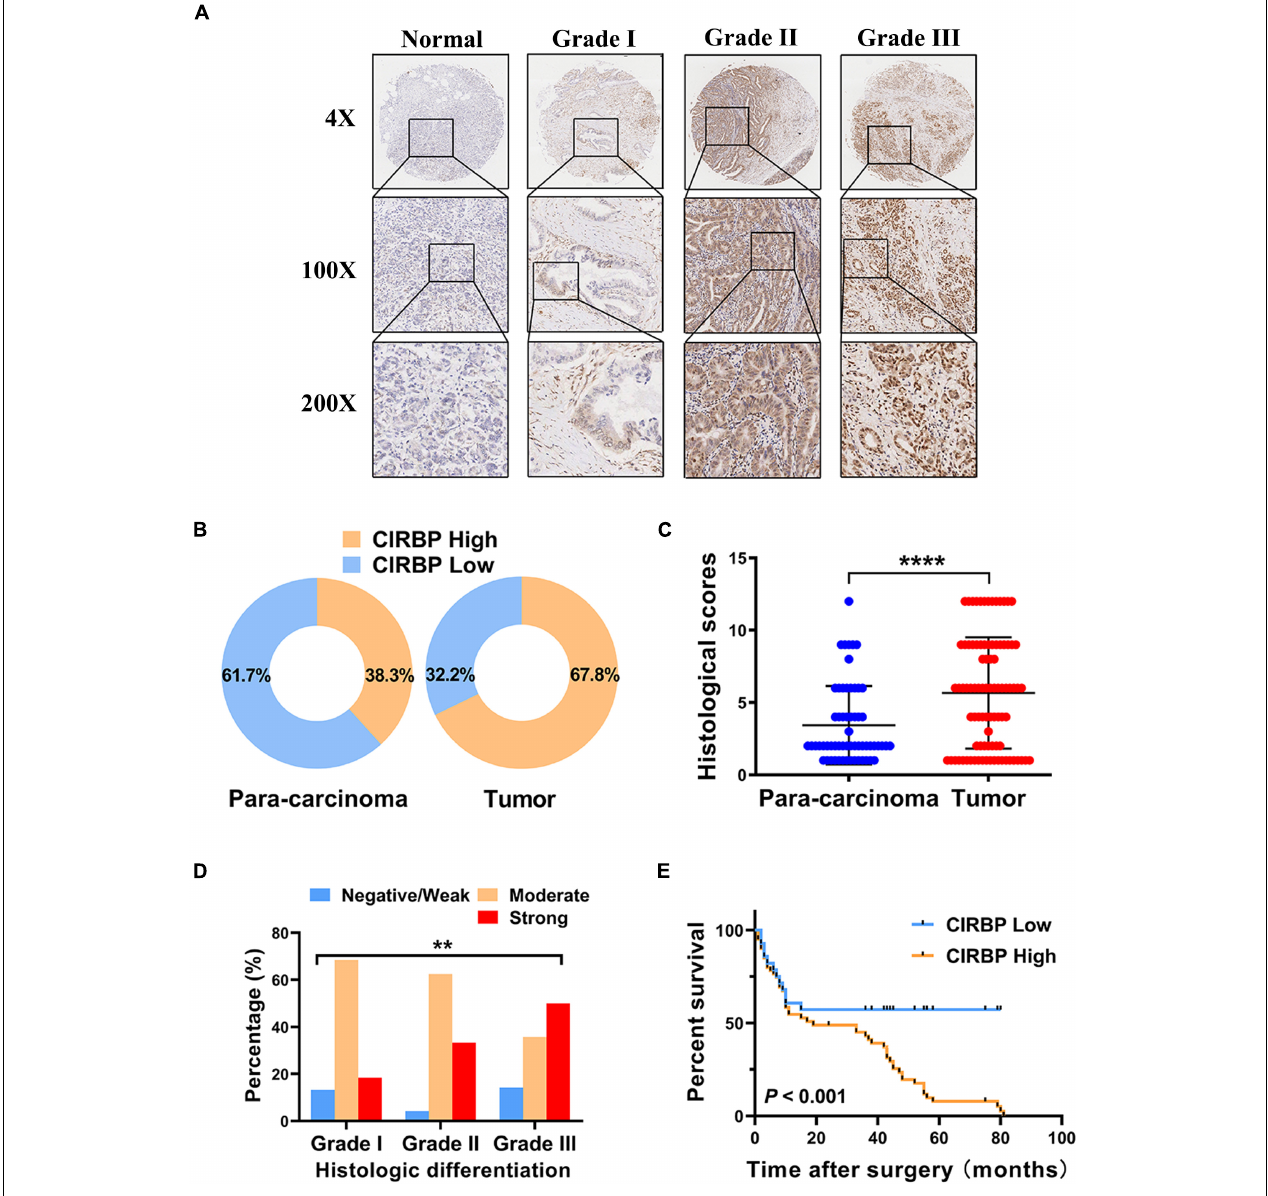
FIGURE 1 | Increased expression of CIRBP is correlated with poor prognosis of pancreatic cancer patients. (A) Representative images of CIRBP staining in pancreatic cancer tissue microarrays with specimens at different differentiation grades or normal adjacent tissues. (B) CIRBP expression in human pancreatic cancer (right, n = 90) and corresponding para-carcinoma tissues (left, n = 60). The patients were divided into CIRBP-high group (histological score ≥ 3) and CIRBP-low group (histological score < 3) by histological score (staining intensity × positive percentages) according to the Fromowitz standard. (C) The histological scores for CIRBP staining in pancreatic cancer and para-carcinoma tissues. (D) The association between the expression of CIRBP and histologic differentiation grades in pancreatic cancer patients. (E) High CIRBP expression was associated with poor overall survival. Data are presented as means ± SD. ** P < 0.01, **** P < 0.0001, unpaired student’s t